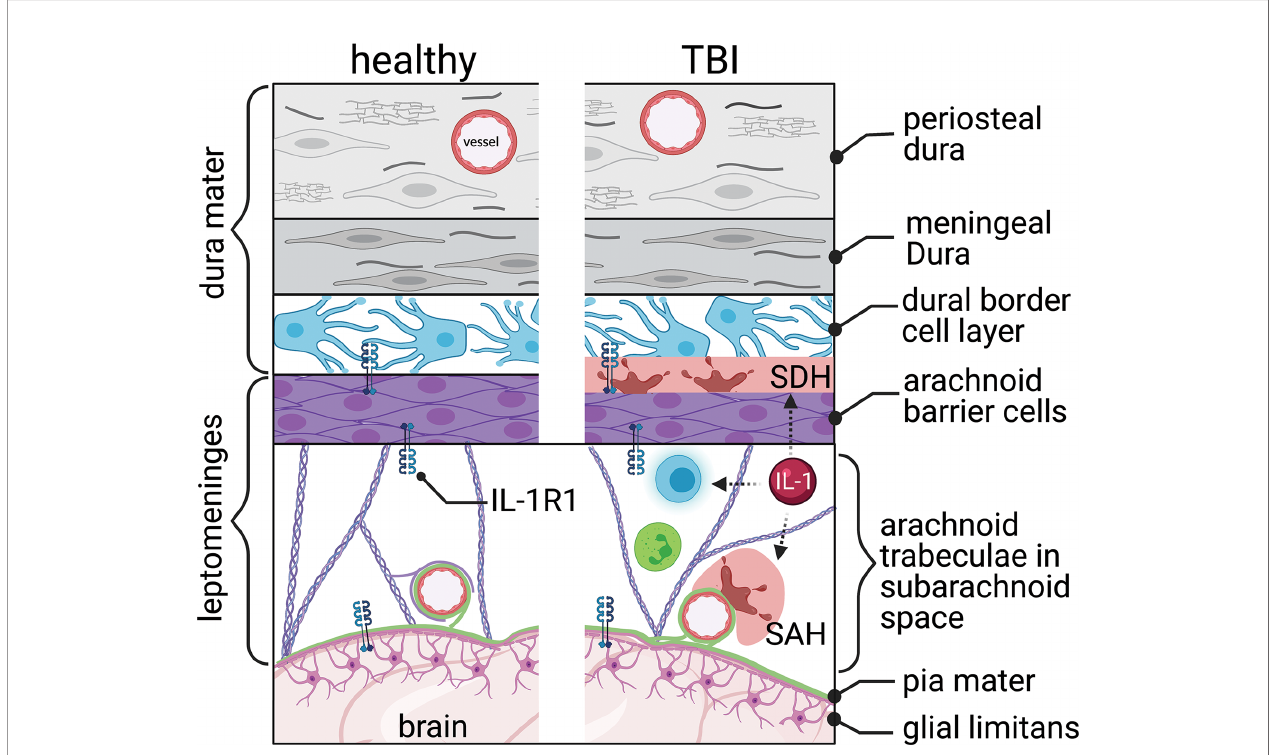
FIGURE 4 | The meningeal barrier. The meninges, covering the brain surface, consist of three main layers, the dura mater, the arachnoid mater, and the pia mater. The dura mater consists of the periosteal, meningeal, and dural border cell layers. The arachnoid trabeculae imparts the majority of the barrier properties. The pia mater covers the brain ’ s surface and connects with the astrocytic end-feet ’ s glial limitans. Interleukin-1 receptor 1 (IL-1R1) is located within the arachnoid and pia mater. Traumatic brain injury tears the blood vessels running through and covered by the meninges, resulting in subdural hemorrhage (SDH) and subarachnoid hemorrhage (SAH). Increased immune cell traf fi cking occurs through the altered meninges post-TBI. IL-1 signaling can be linked indirectly (dashed arrows) with hemorrhage and leukocyte traf fi cking and